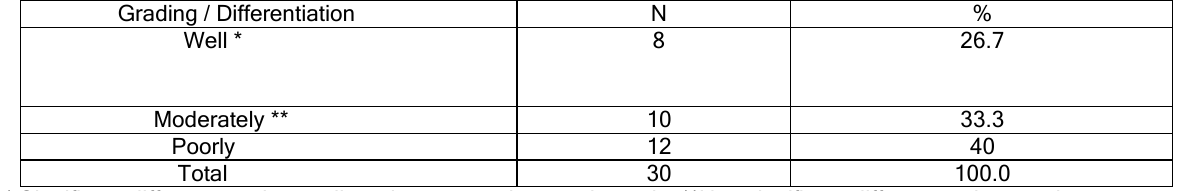
Table ( 2) : Grading of Breast cancers group.